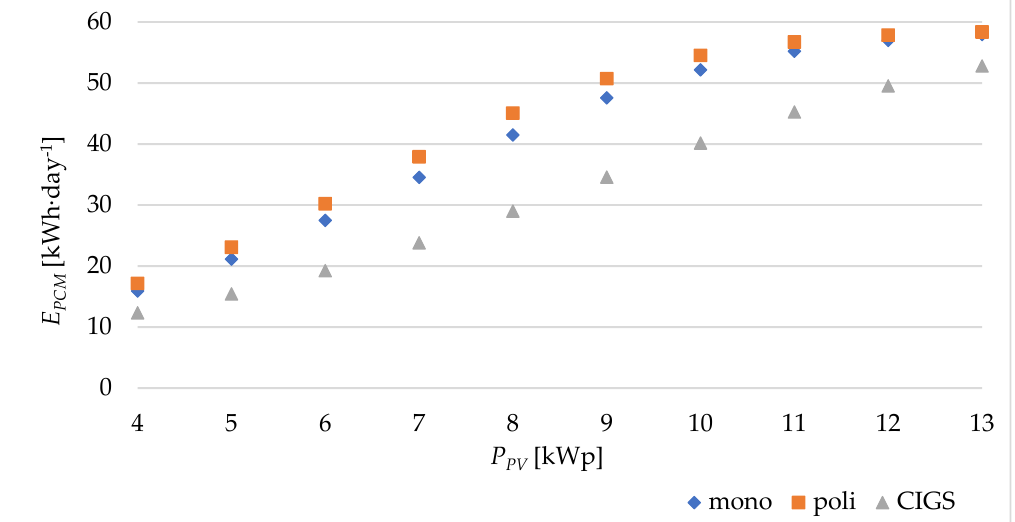
Figure 11. The amount of energy stored in the PCM battery as a function of the power of the PV plant for sunny days.